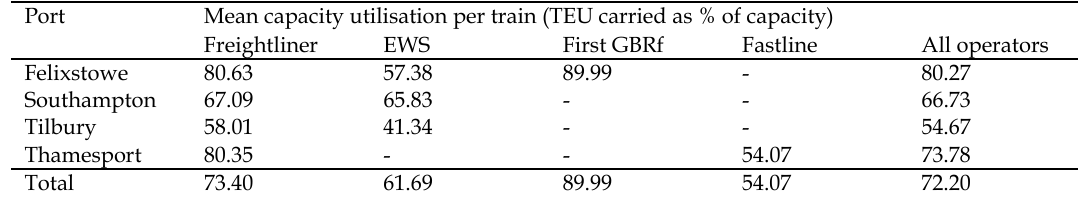
Table 6. Mean TEU capacity utilisation per train, by port and train operator Port Mean capacity utilisation per train (TEU carried as % of capacity) Freightliner EWS First GBRf Fastline All